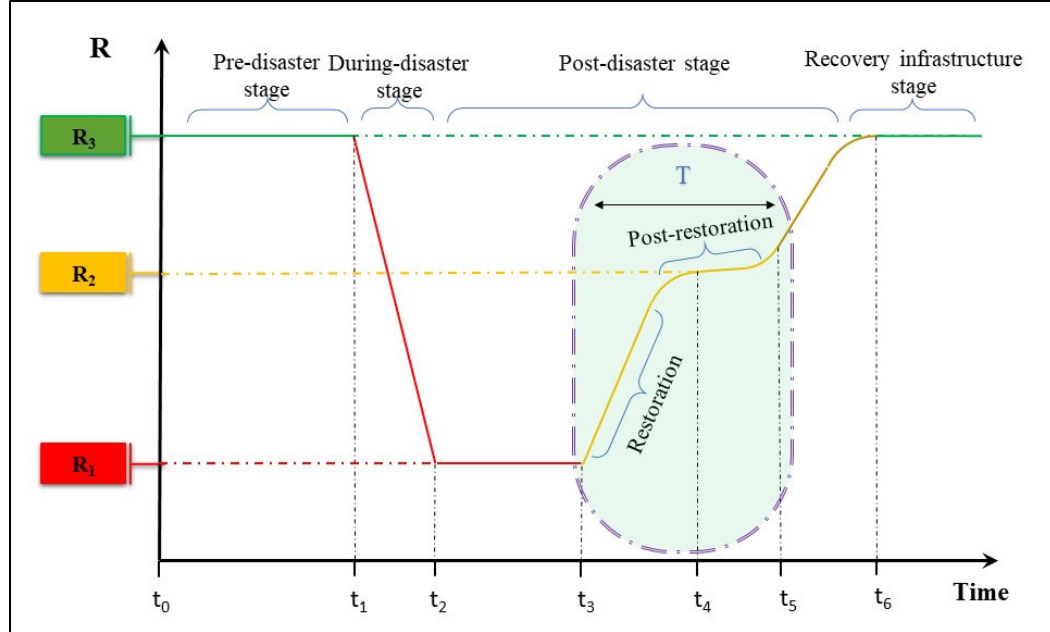
Figure 1. Resilience curves related to a catastrophe.